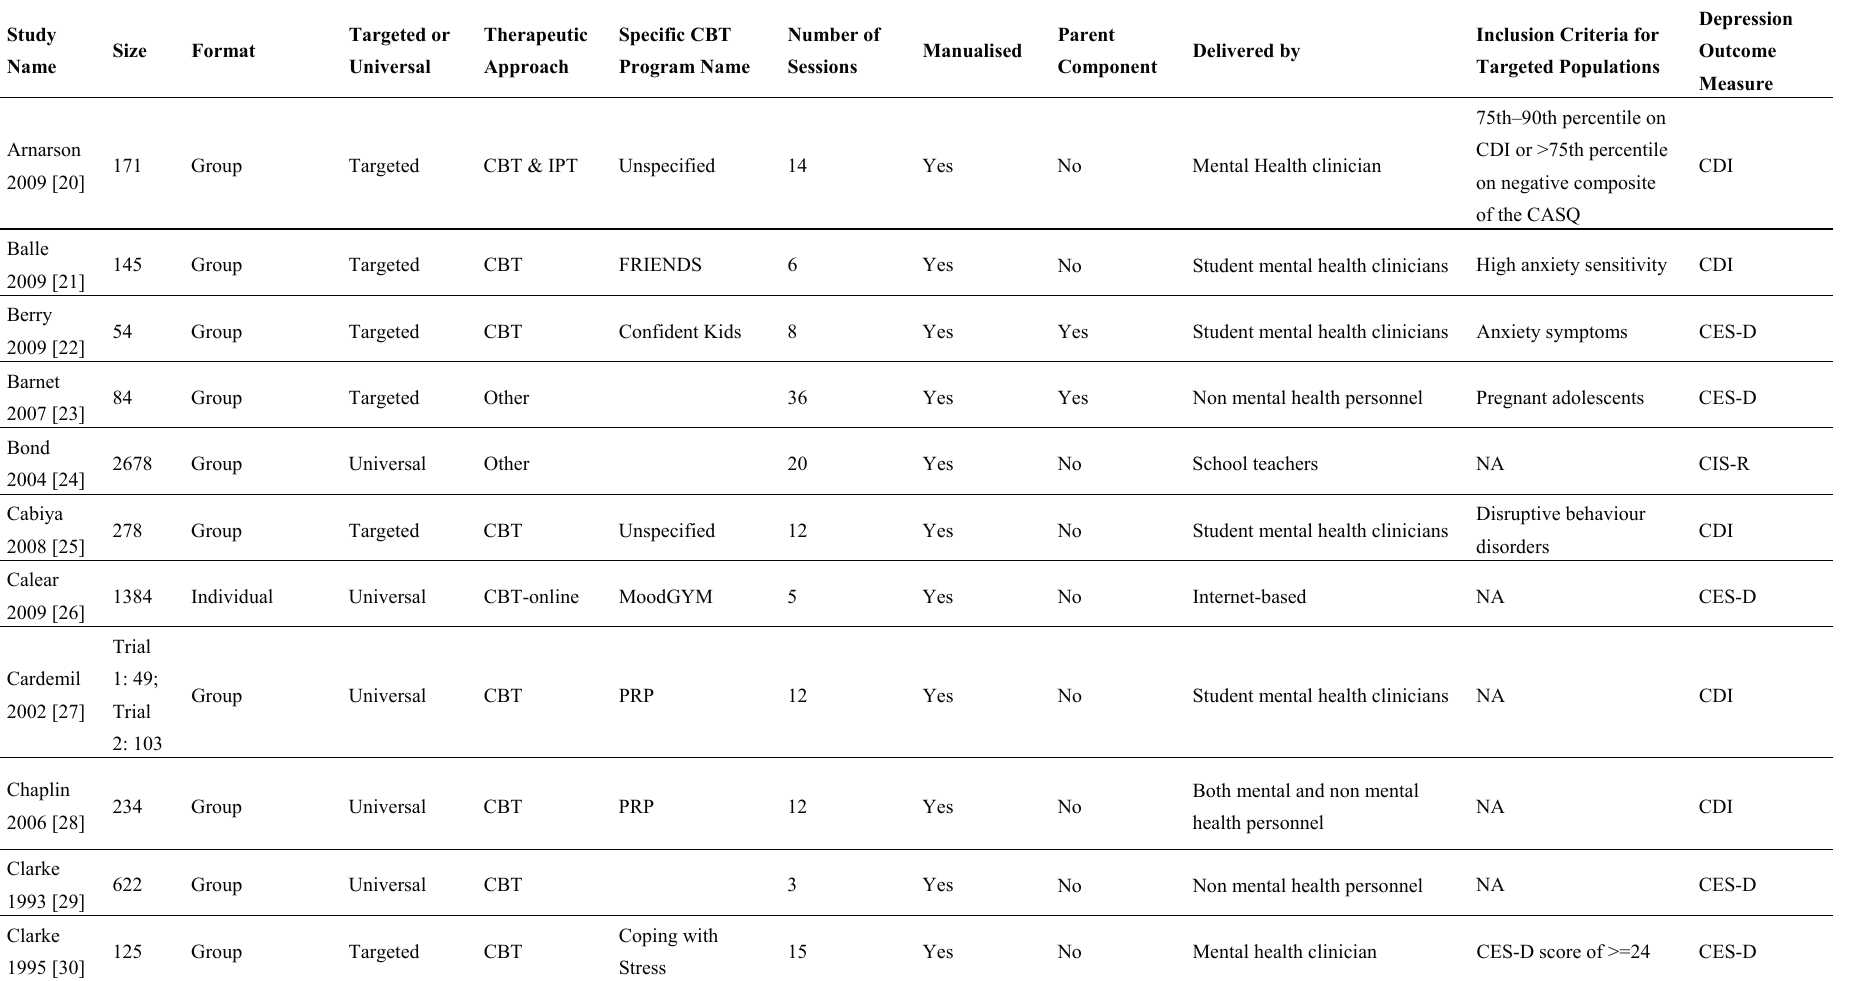
Table 2 . General characteristics of included